Question: Summarize what this figure shows in one sentence.
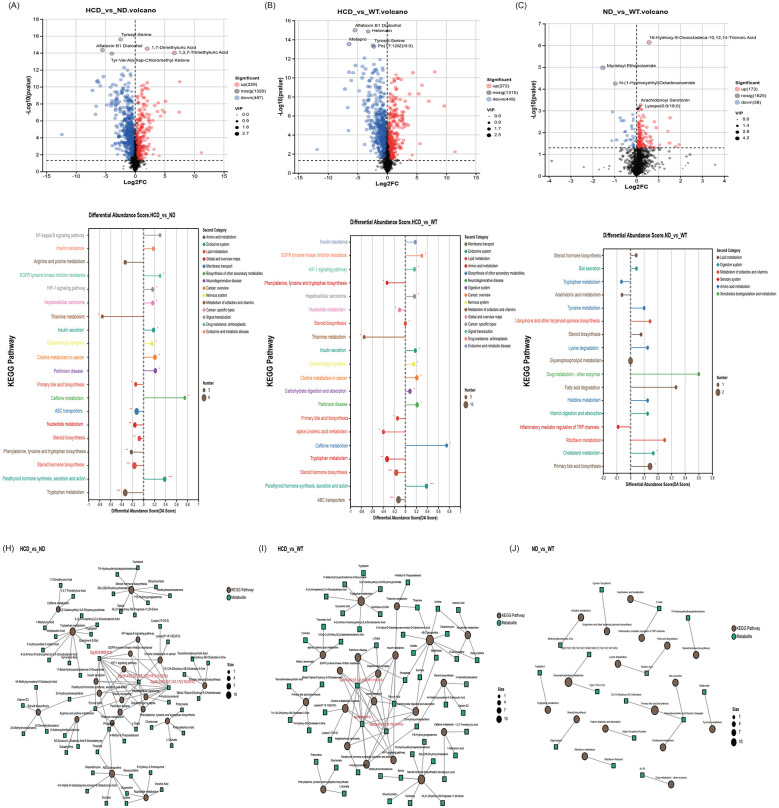
Answer: Comparison of metabolomic expression in colonic content after 12-week Intervention. (A–C) Differentially Metabolites: (A) Volcano plot comparing differential metabolites between the HCD and ND groups; (B) Volcano plot comparing differential metabolites between the HCD and WT groups; (C) Volcano plot comparing differential metabolites between the ND and WT groups; (E–G) Functional Enrichment in Colonic content: (E) Differential Abundance Score: TOP 20 KEGG pathways enriched with differential metabolites between HCD group and ND group; (F) Differential Abundance Score: TOP 20 KEGG pathways enriched with differential metabolites between HCD group and WT group; (G) Differential abundance score: TOP 20 KEGG pathways enriched with differential metabolites between ND group and WT group; (H–J) A network diagram displays the KEGG enrichment results for differential metabolites: (H) Network diagram of KEGG enrichment for differential metabolites (HCD vs. ND); (I) Network diagram of KEGG enrichment for differential metabolites (HCD vs. WT); (J) Network diagram of KEGG enrichment for differential metabolites (ND vs. WT).